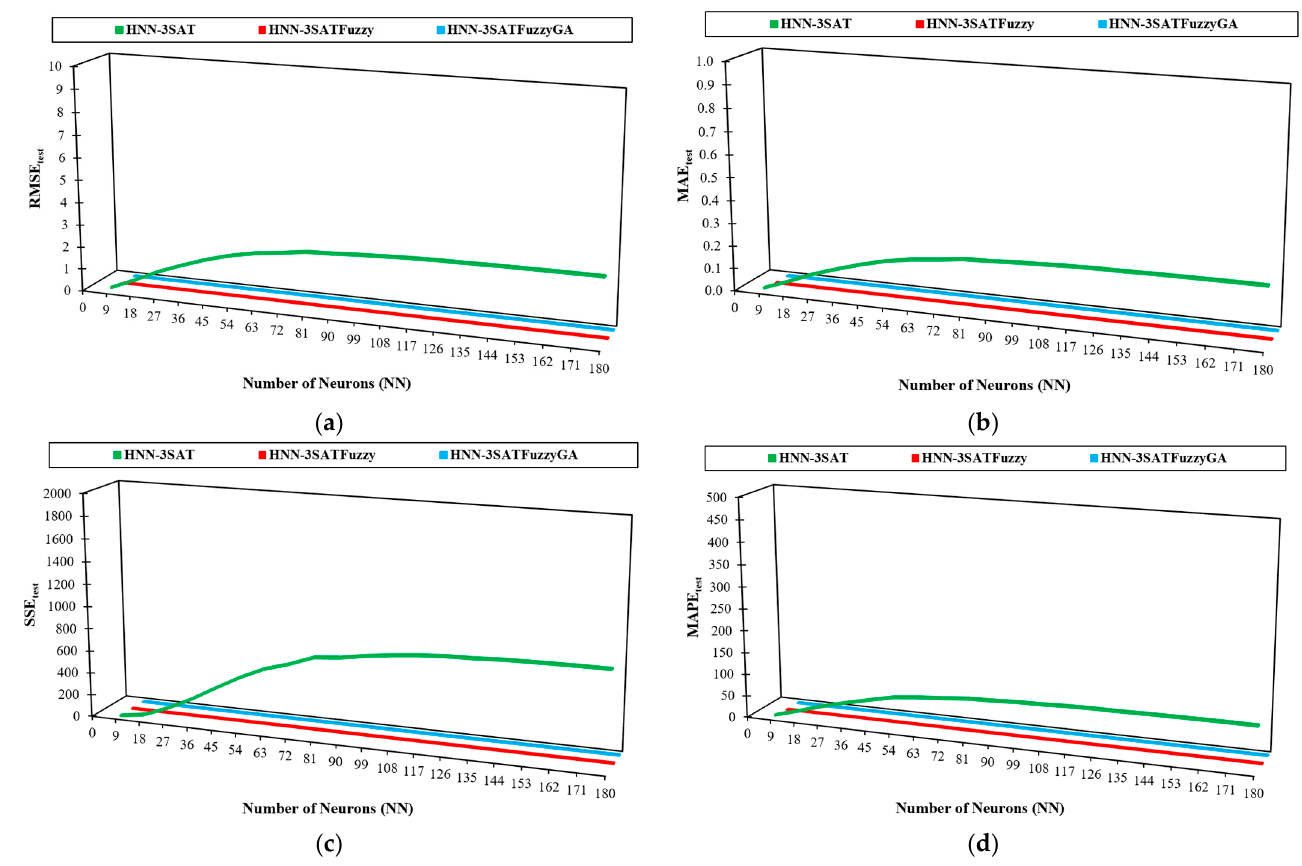
Figure 5. The error analysis metrics in the testing phase: ( a ) RMSE test ; ( b ) MAE test ; ( c ) SSE test ; ( d ) MAPE test .